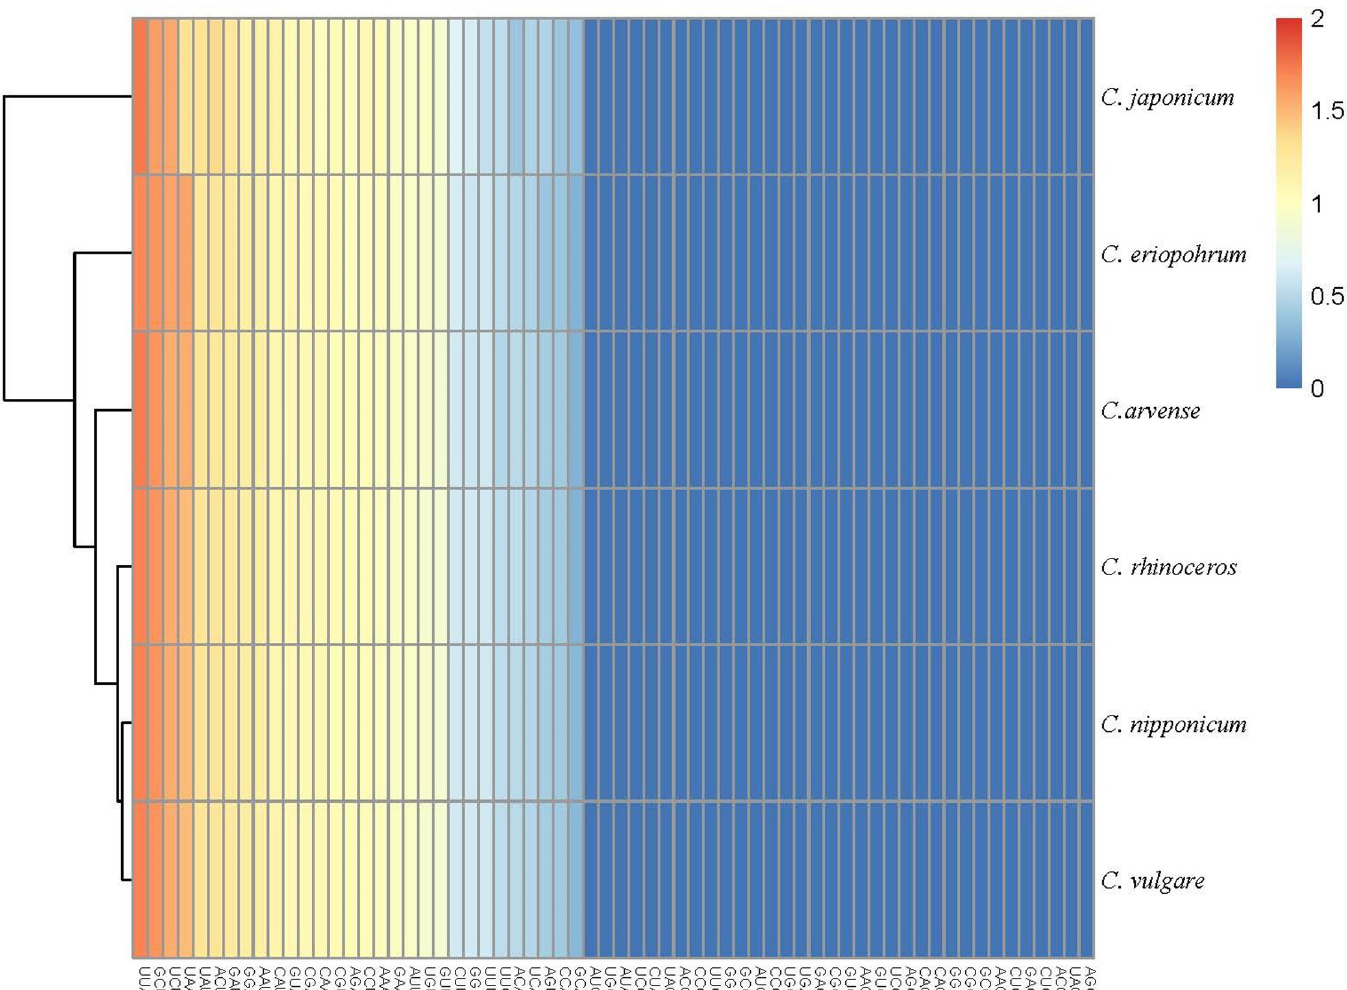
Fig 3. Heat map of relative synonymous codon usage values of chloroplast protein coding genes among six Cirsium species.